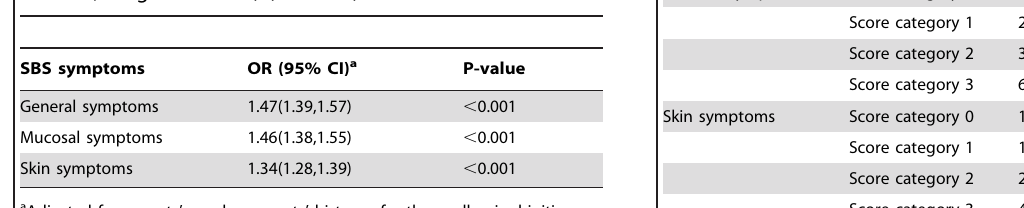
Table 6. There were significant associations between the Continuous OH-score and all types of SBS symptoms. Stratifying for gender, using the same model as Table 6, showed similar associations between SBS symptoms and Continuous OH-score in men and women (data not shown). Associations between SBS symptoms and the Categorized OH- score were calculated by multiple logistic regression (Table 7). Results show that the numbers of odor or humidity perceptions were positively associated with SBS symptoms. Stratifying for gender, using the same model as Table 7, showed similar associations between SBS symptoms and Categorized OH-score in men and women (data not shown).